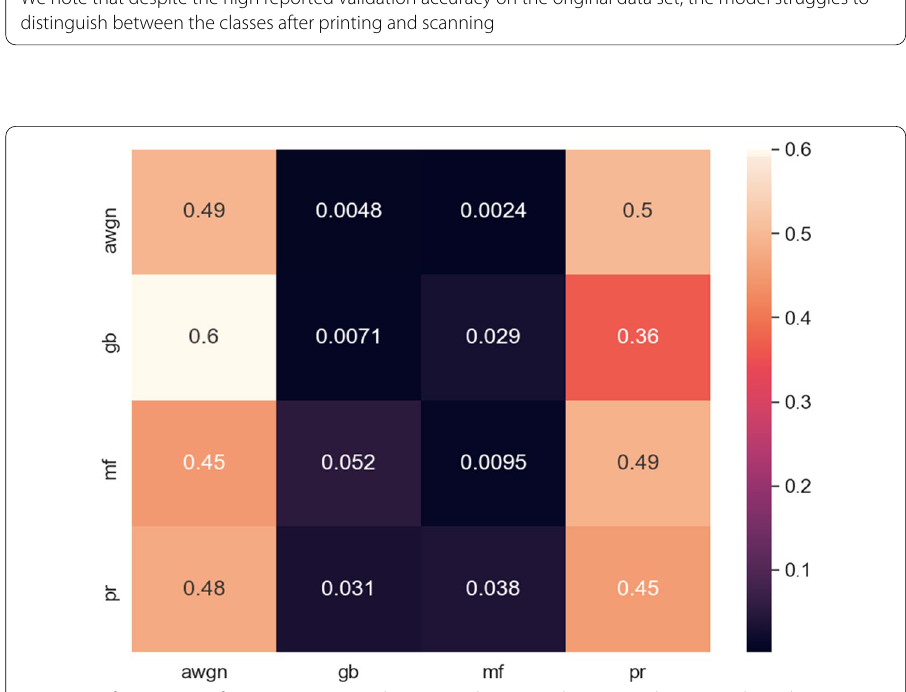
Fig. 5 Confusion matrix for Bayar2016 trained on Original IFSTC (without RS and JPEG), evaluated on Xerox1 (see Table 2). We investigate the model’s performance after removing bilinear resampling (RS) and JPEG compression, but find that it still performs little better than